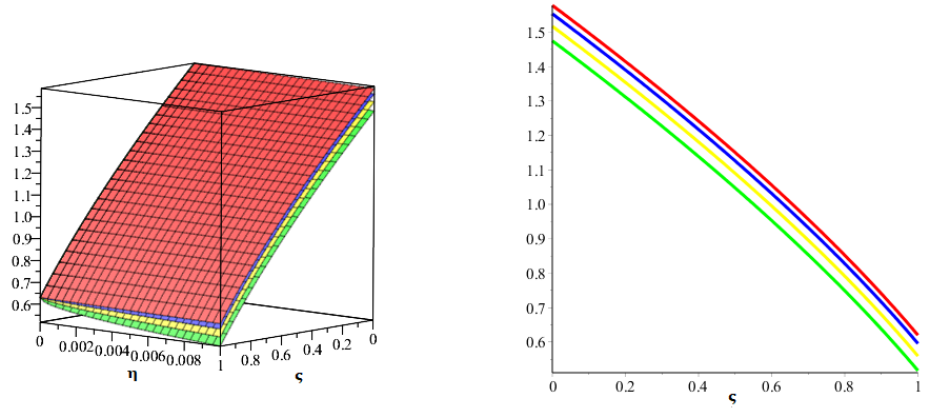
Figure 9. The proposed method solution at different values of γ for example